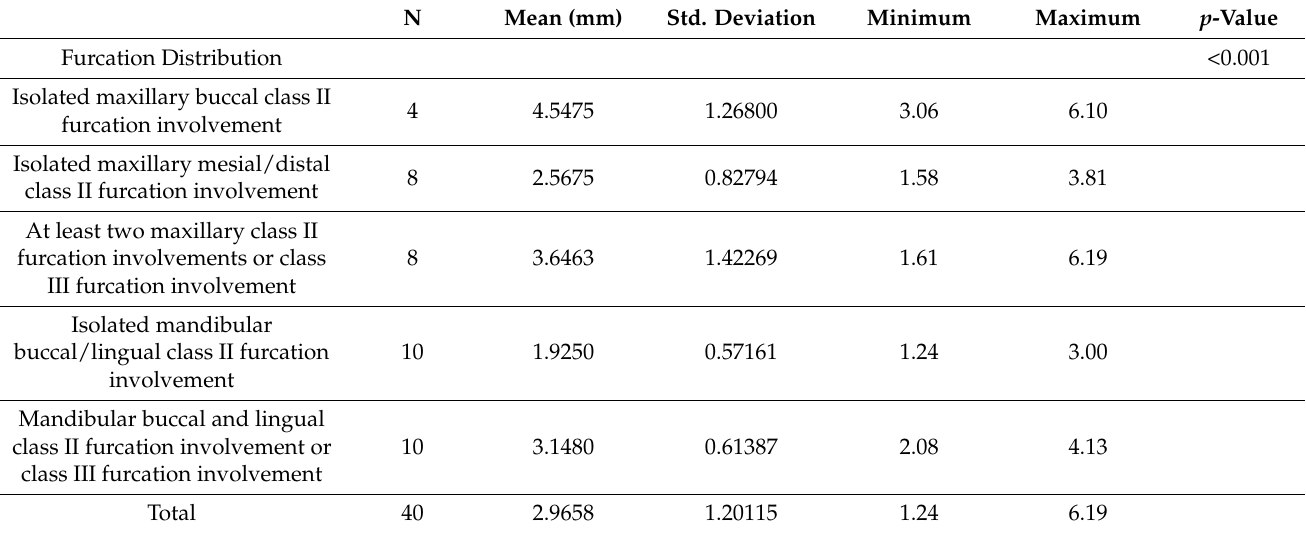
Table 5. Descriptive statistics and one-way ANOVA comparing the vertical depth of furcation involvement in different furcation involvement distribution subgroups as measured on CBCT.